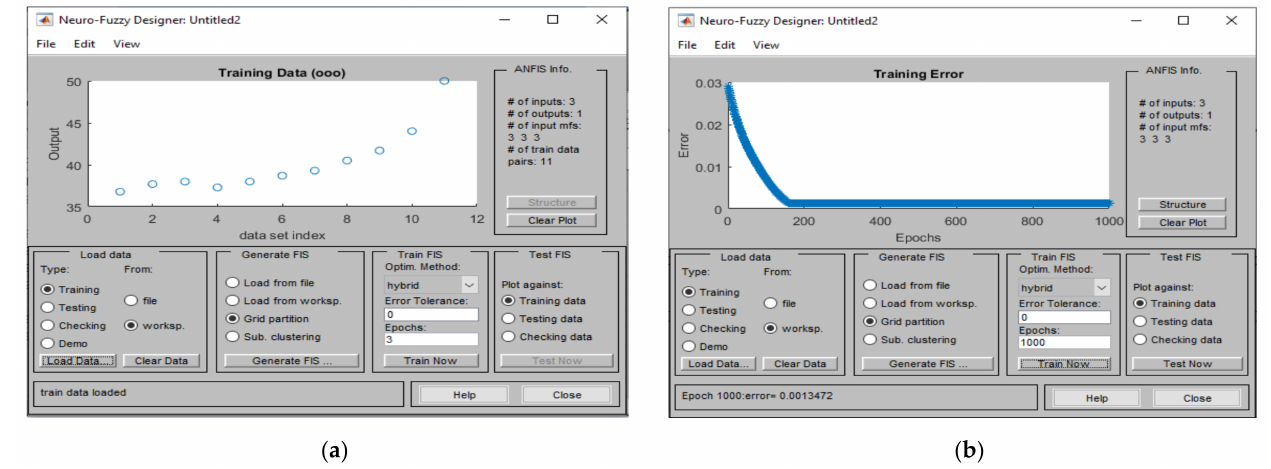
Figure 15. Training ( a ) datasets; and ( b ) error with 1000 epochs. Regulator structure, treated in the MATLAB-Simulink environment, is presented in Figure 16.